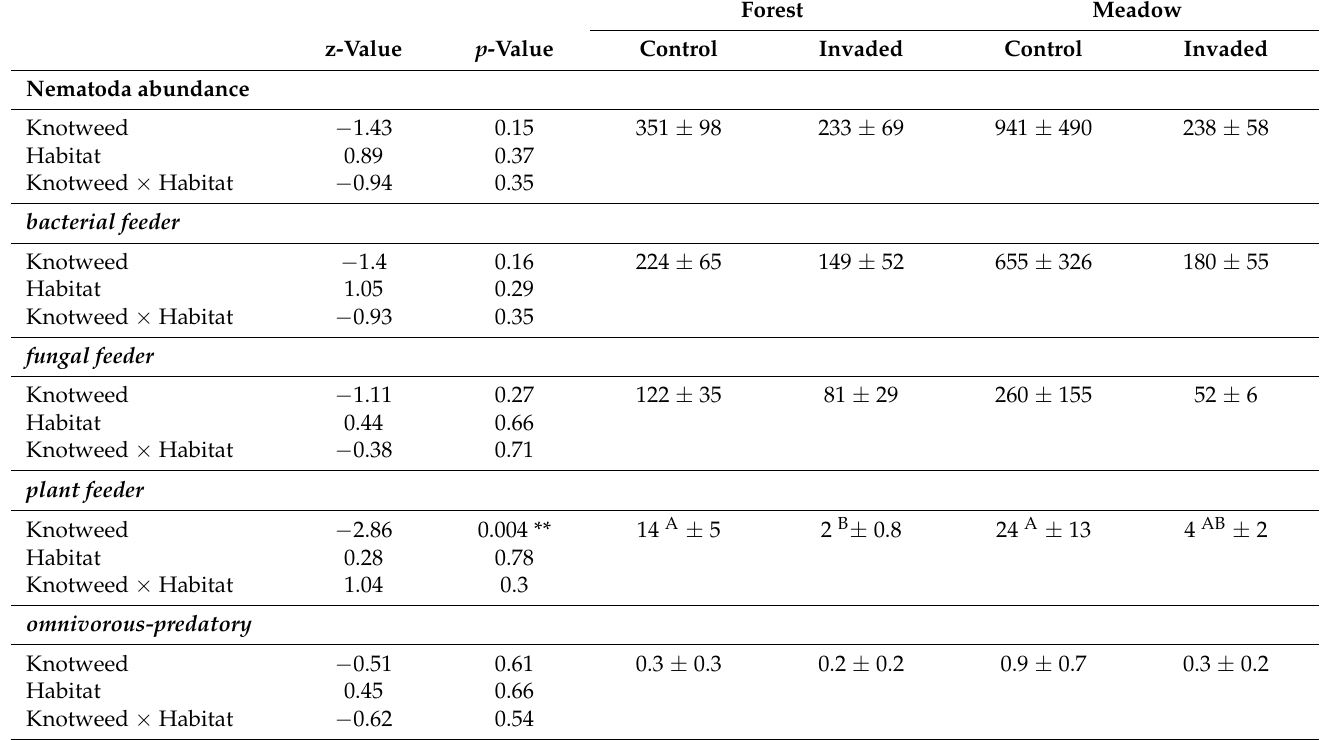
Table 3. Effects of the factors “Knotweed” with two levels: presence or absence, “Habitat” with two levels: forest or meadow and their interaction on Nematoda abundances (ind.100 g of dry soil). Values are means ± standard errors. z-values and associated p -values were obtained from GLMM with a binomial negative distribution (zero-inflated models). Two values in the same row with a different letter are significantly different according to Tukey post hoc tests. ** denotes statistical significance at p = 0.01. When the p -values obtained from GLMM were not significant, the post hoc test results are not